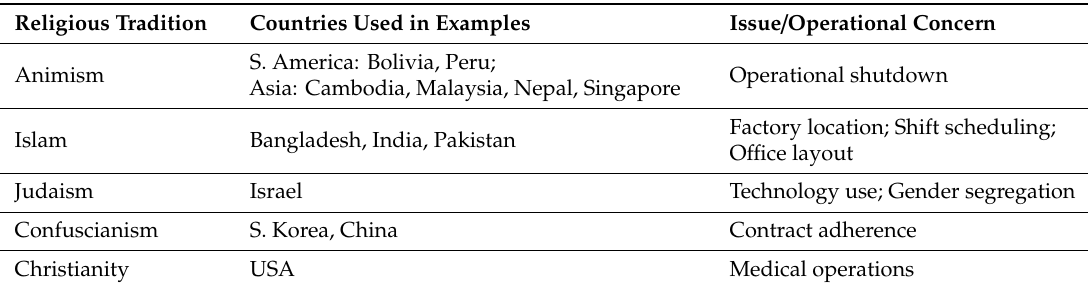
Table 1. E ff ect on business operations by